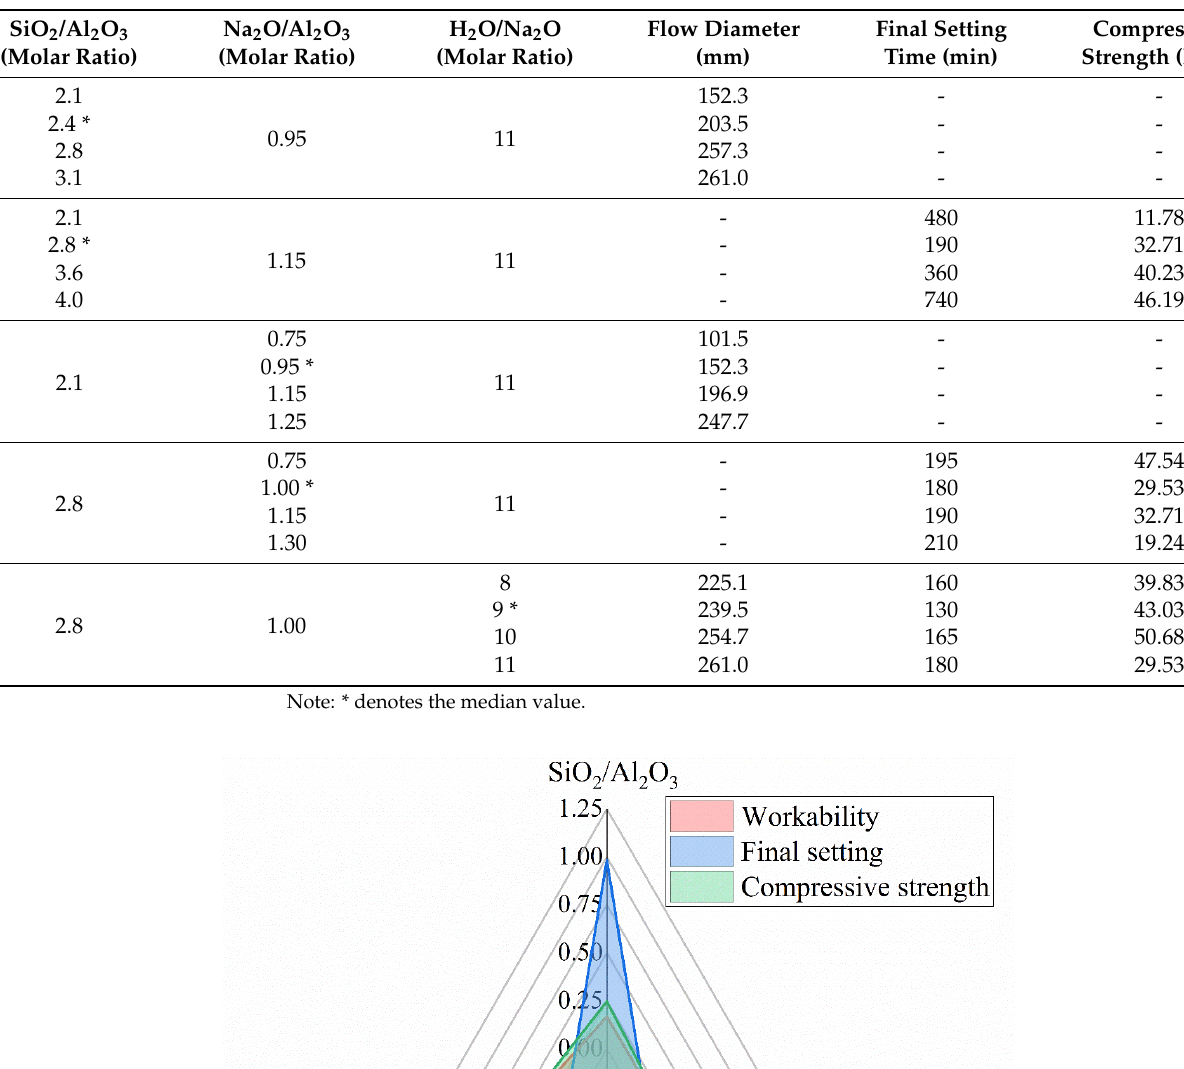
Table 4. Representative outcomes used for sensitivity analysis.